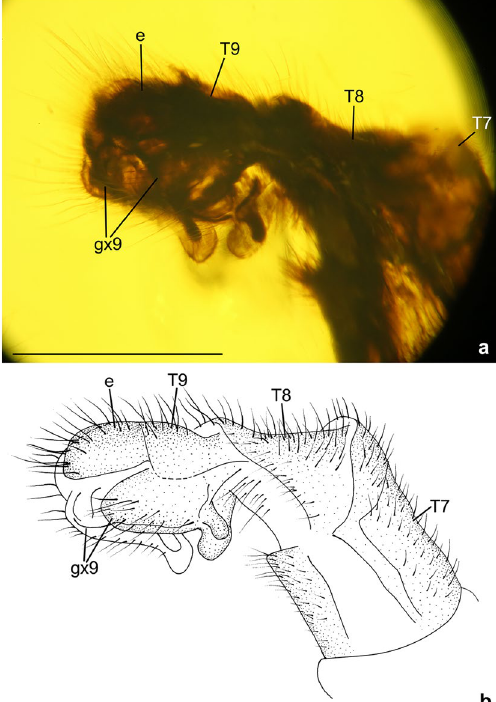
Figure 9. Xiaobabinskaia lepidotricha sp. nov., holotype female. ( a ) photograph of genitalia, lateral view; ( b ) drawing of genitalia, lateral view (drawn by XML). Scale bar = 1.0